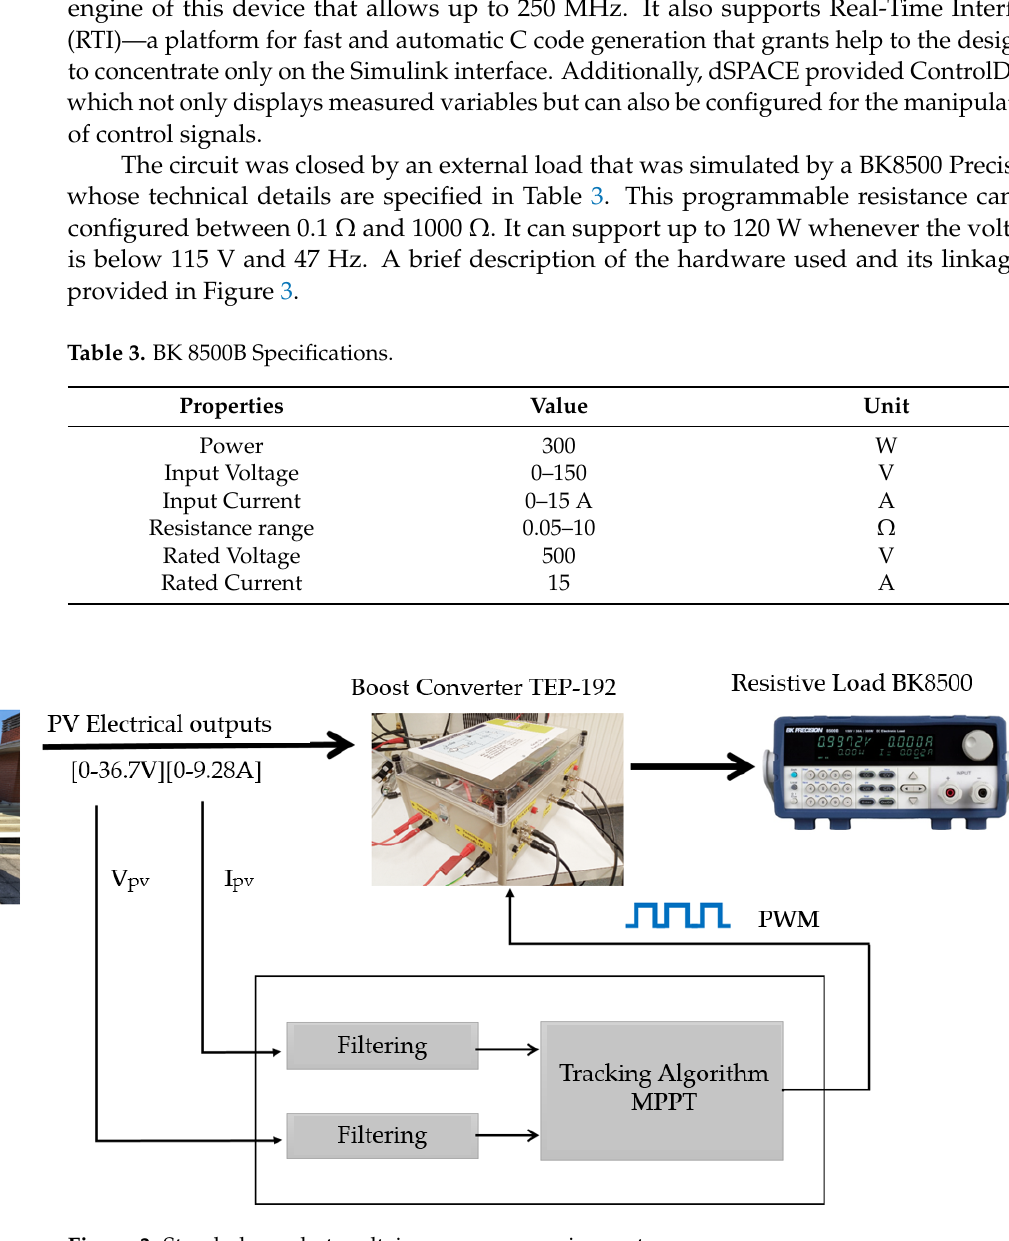
Figure 3. Stand-alone photovoltaic energy conversion